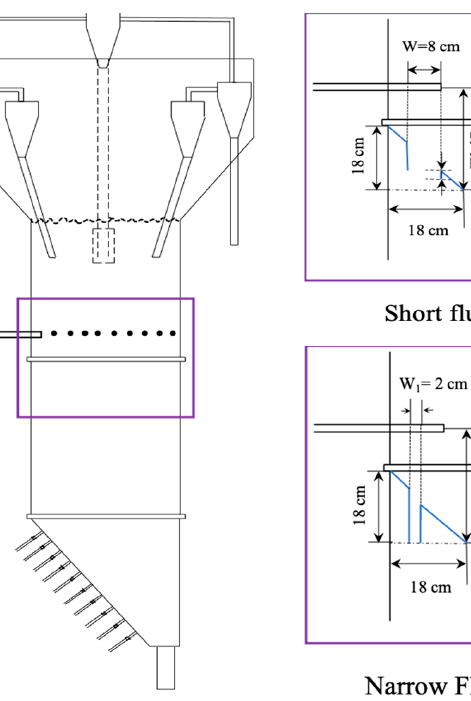
Figure 2. Location and dimensions of different baffles.